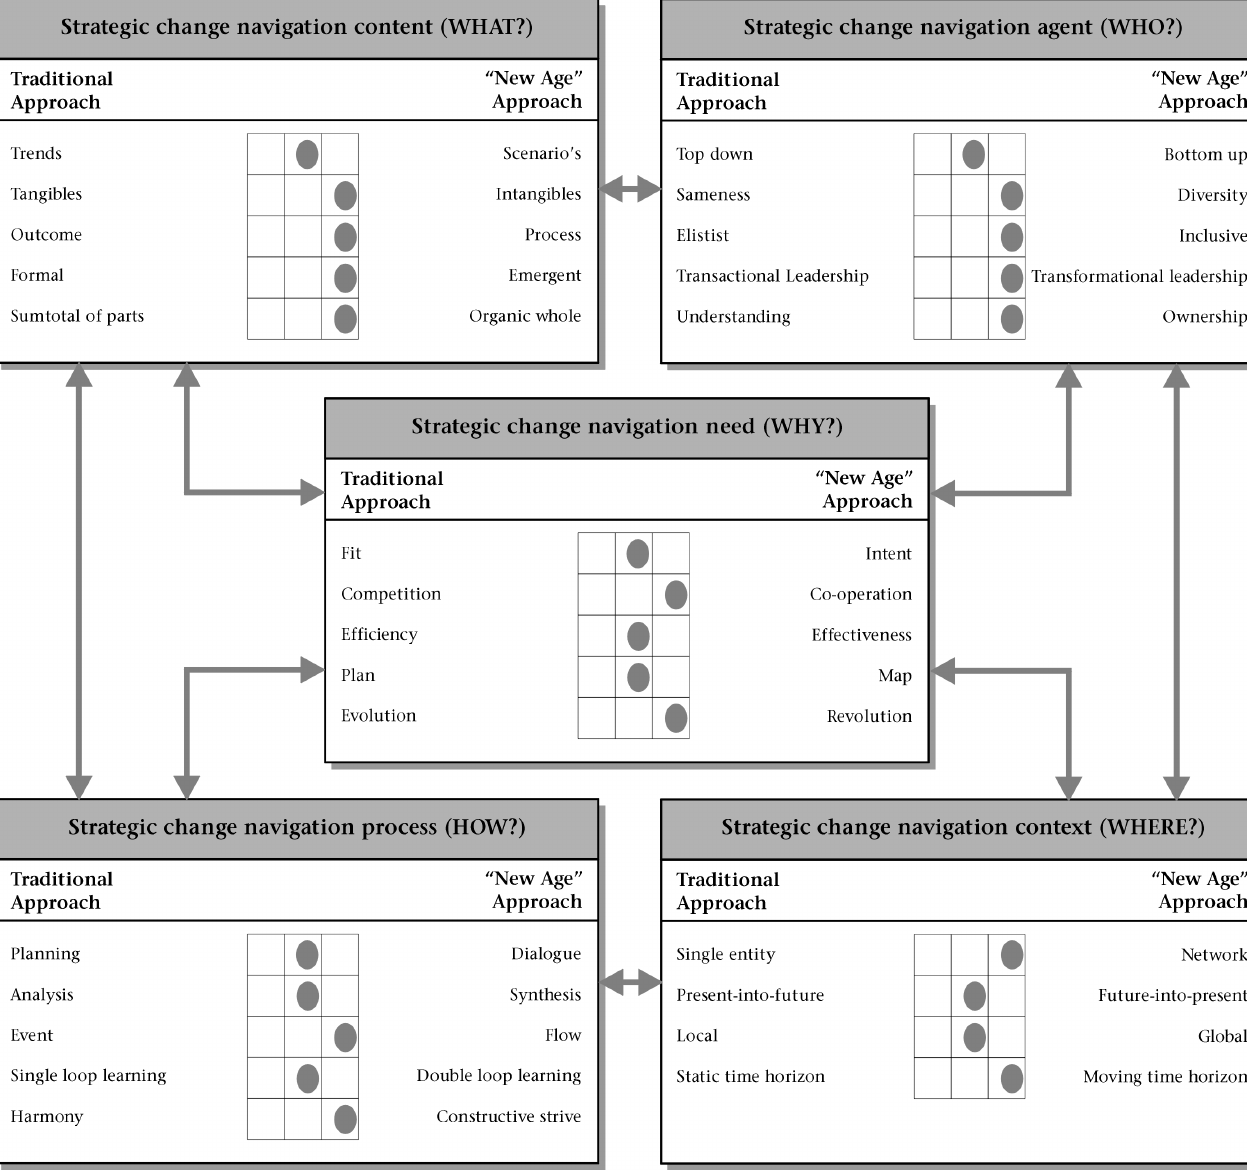
Figure 2: Assessment of Swanepoel’s (2001) Integrated Strategic Management Model against the Key Abilities making up the Core Competence of Strategic Change Navigation suggested by Veldsman